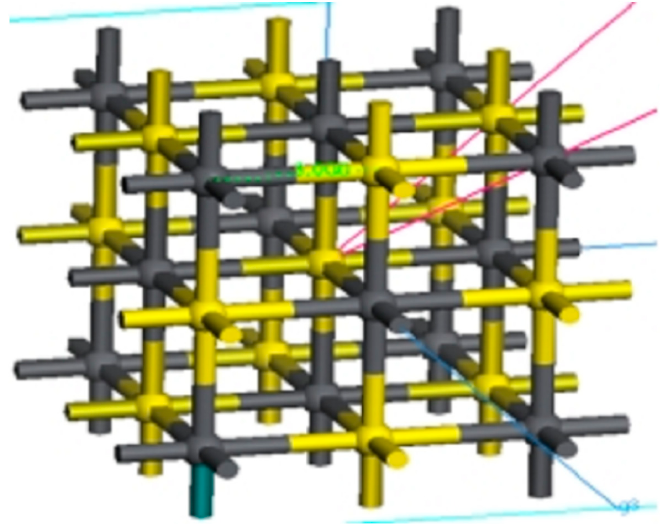
Figure 3. Optimized crystal structure of perfect galena (Yellow: S atoms; Gray: Pb atoms).